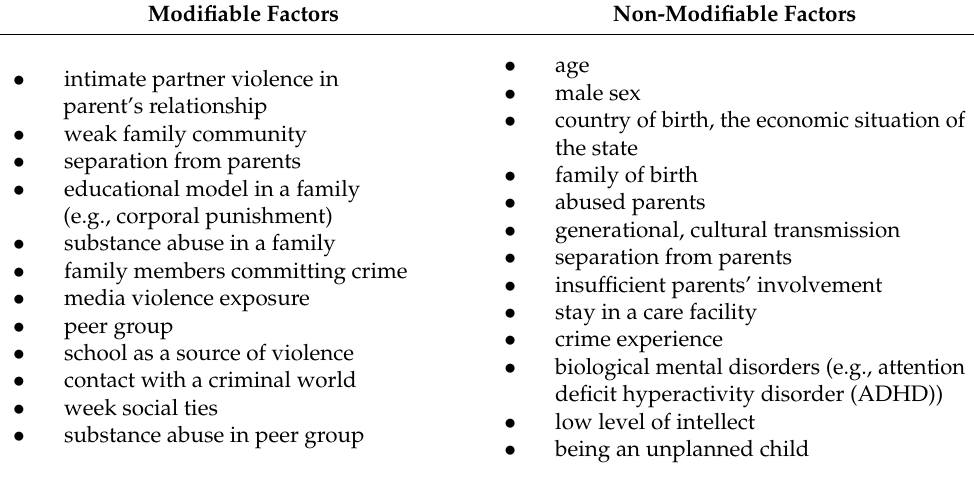
Table 1. Risk factors for